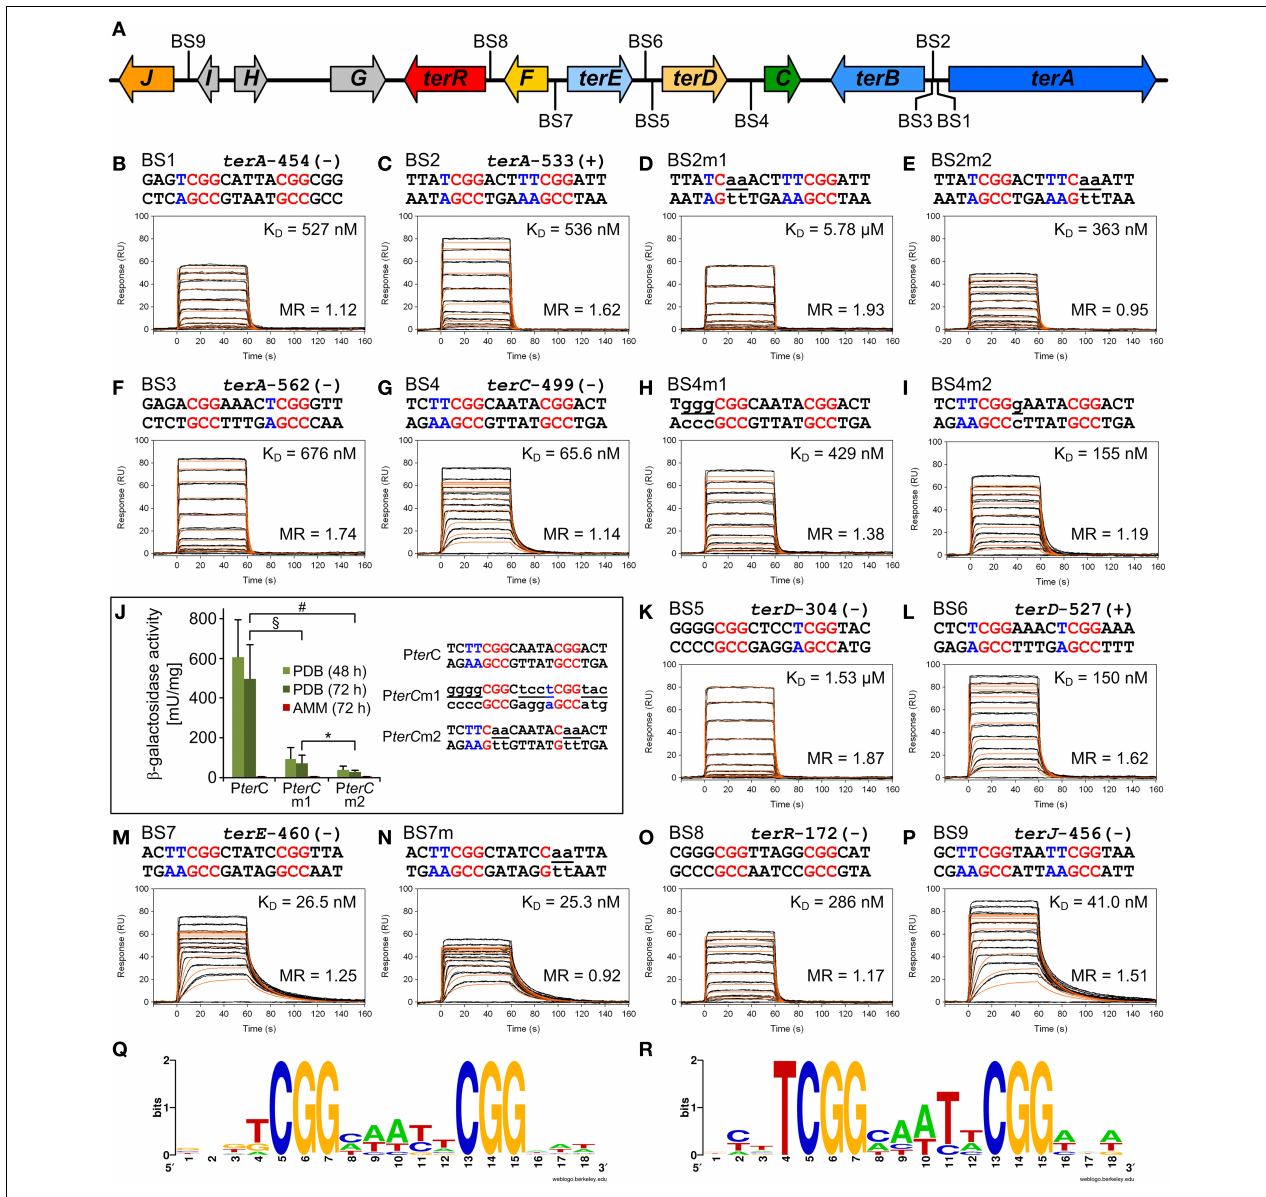
FIGURE 3 | In vitro TerR binding to a consensus motif identified in promoters of the A. terreus terrein biosynthesis gene cluster and in vivo verification of in vitro data. (A) Schematic presentation of the terrein gene cluster. Intergenic positions of the consensus TerR-binding motif identified by the SCOPE motif finder suite (Q) are annotated with BS1–9. (B–I,K–P) Real-time in vitro SPR interaction analysis of TerR 35 − 138 with DNA containing the predicted natural or mutated (denoted by the letter “m”) binding sites from promoters of terrein cluster genes. Sequences of DNA duplexes used for SPR analysis are shown on top of the sensorgrams. Numbers represent the CGG direct repeat motif positions relative to the start of the open reading frame. CGG half-sites and 5 ′ -flanking thymidines are highlighted in red and blue. Substituted nucleotides relative to the wild-type sequence are underlined and shown in lowercase letters. TerR 35 − 138 binding responses from triplicate injections of different concentrations (black lines) are overlaid with the best fit derived from a 1:1 interaction model including a mass transport